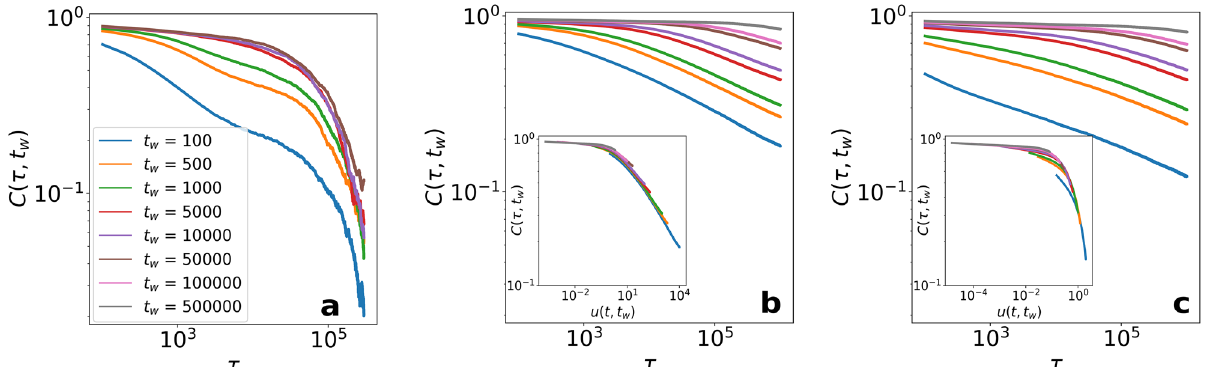
Figure 5. Two-times autocorrelation C (τ , t w ) as a function of the time period passed since the waiting time t w . First, the autocorrelation is shown for the Schelling model at 0.71 in ( b ) and T 0.86 in ( c ). The insets are the result of the collapse using u (τ , t w ) aging at T = = t w )/ log ( t w ) log (τ 1 ( c ). The curves correspond to different values of the waiting time t w . and u (τ , t w ) = + − 100 lattice averaged over 5 Calculations performed on a 100 ×